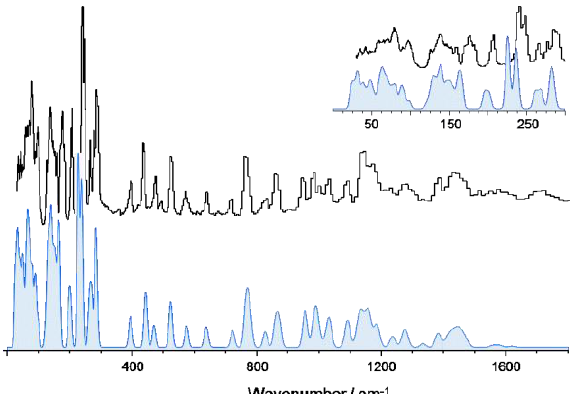
Figure 2. The INS spectra of 2MeOB up to 1800 cm − 1 : experimental ( top ) and simulated from periodic DFT calculations ( bottom , CASTEP). The inset provides a detailed view of the low wavenumber region.